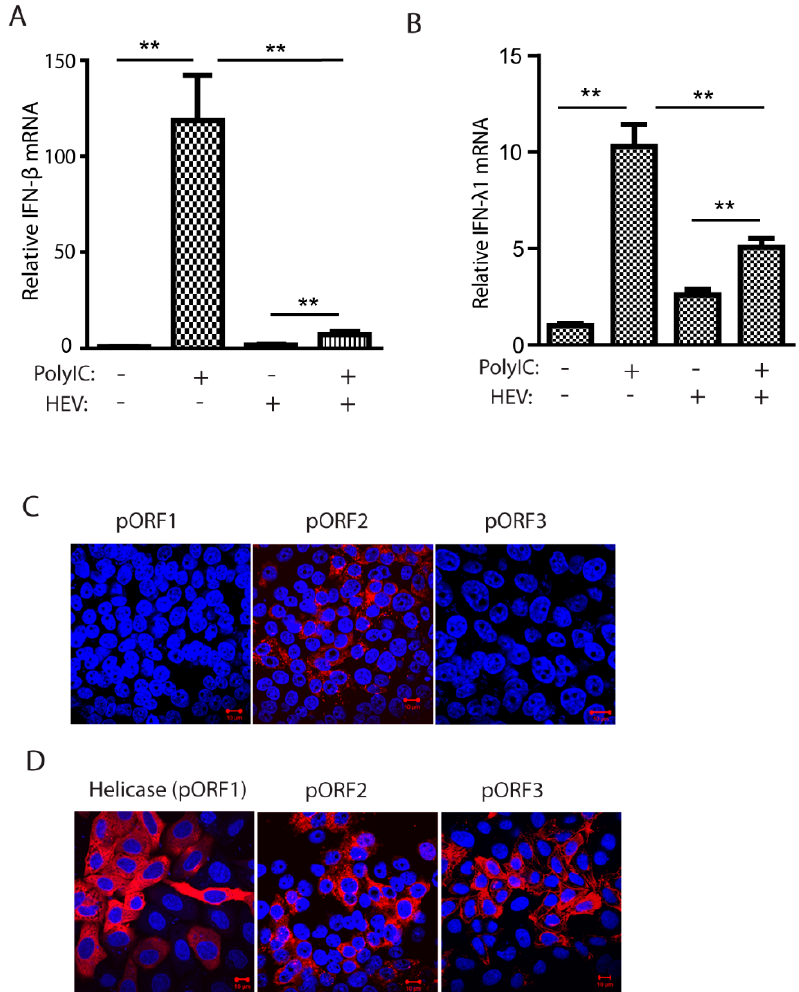
Figure 1. Hepatitis E virus (HEV) infection downregulates interferons (IFN) induction. ( A ) HEV inhibits poly(I:C)-induced IFN- β expression in HepG2/C3A cells. The cells were infected by HEV Kernow-P6 strain and transfected with poly(I:C) at 6 µg/mL and, 8 h later, harvested for RNA isolation and real-time PCR. Significant differences between the poly(I:C)-treated samples are denoted with ** for p < 0.01. ( B ) HEV inhibits poly(I:C)-induced IFN- λ 1 expression in HepG2/C3A cells. ( C ) Indirect immunofluorescence assay (IFA) of the HepG2/C3A cells infected with Kernow-p6. Antibodies against HEV helicase (pORF1), pORF2, and pORF3 proteins were used. Red indicates HEV-positive staining, and blue is DAPI staining of nuclear DNA. The scale bar in the lower right of the images denotes 10 µm. ( D ) IFA of HeLa cells transiently transfected with plasmids of helicase, ORF2, and ORF3. IFA was done with antibodies against HEV helicase, pORF2, and pORF3 proteins. The scale bar in the lower right of the images denotes 10 µm.